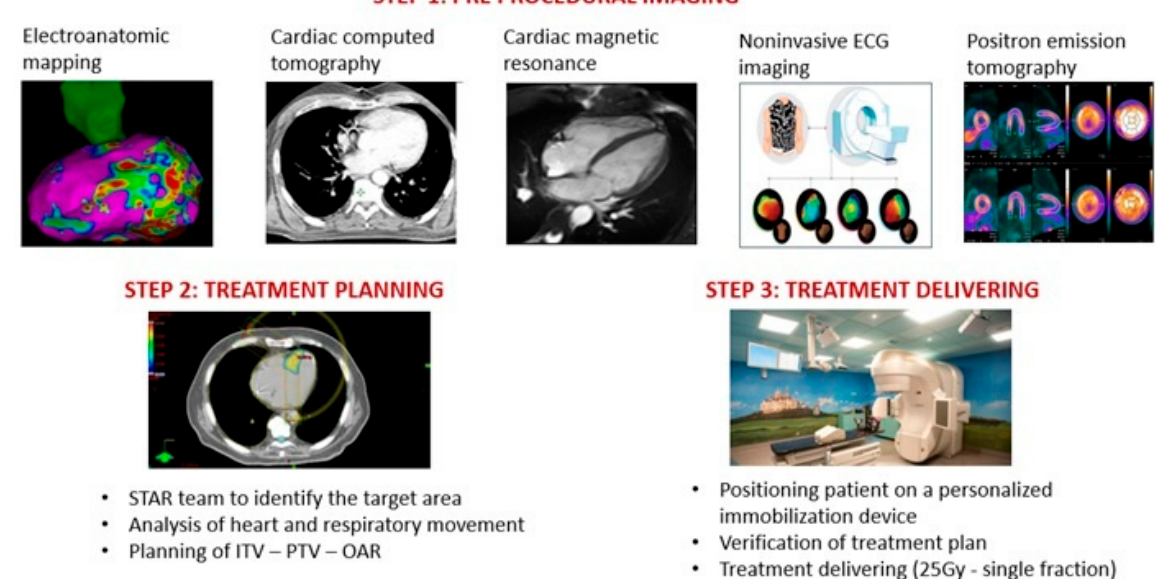
Figure 2. STEP 1, STEP 2, and STEP 3 interventional workflow for STAR. ITV (internal target volume), PTV (planning target volume), OAR (organs at risk).